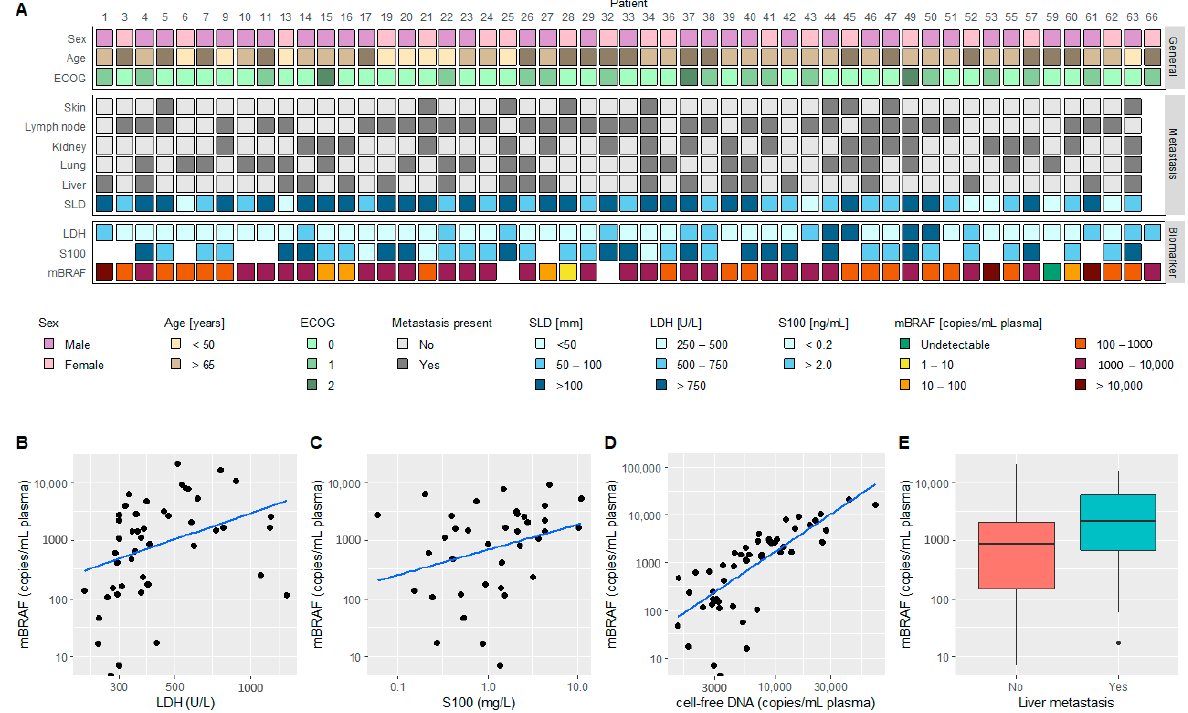
Figure 1. Baseline patient characteristics and clinicopathologic features in relation to baseline plasma mBRAF copies. ( A ) Schematic overview illustrating the patient characteristics (sex, age, ECOG), metastasis sites and blood-based biomarkers (LDH, S100) relative to the plasma mBRAF copies; ( B ) Correlation between plasma mBRAF copies and LDH levels ( ρ = 0.50, p < 0.001); ( C ) Correlation between plasma mBRAF copies and S100 levels ( ρ = 0.35, p = 0.03); ( D ) Correlation between plasma mBRAF copies and total cell free circulating DNA copies ( ρ = 0.83, p < 0.001); ( E ) Association between plasma mBRAF copies and the presence of liver metastasis ( p = 0.05).